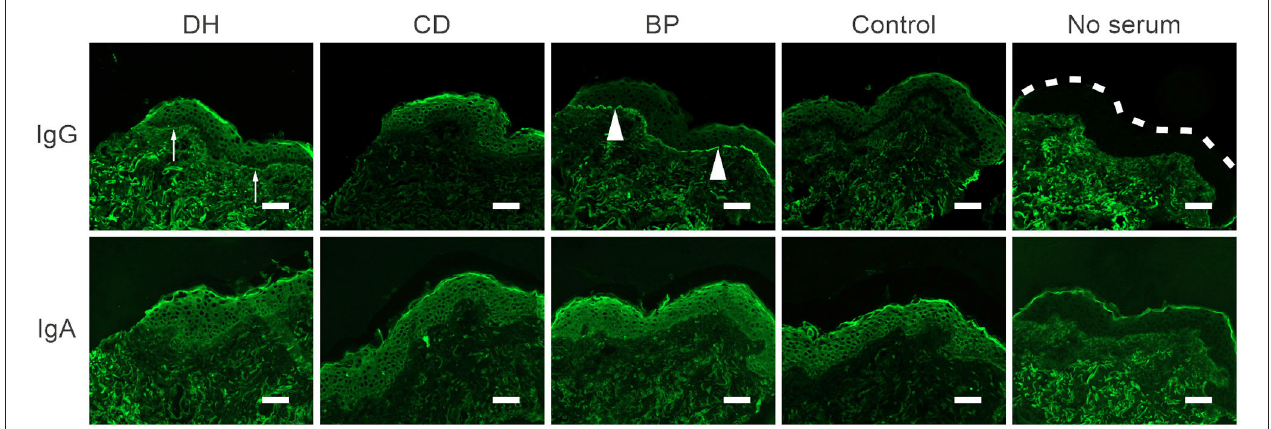
FIGURE 4 | Autoantibodies in DH, CD and control sera do not react with the cutaneous basement membrane zone. Representative images of indirect immunofluorescence (IIF) analysis in frozen human skin sections. 13 DH, 9CD, and 9 control sera were tested with anti-human IgG-FITC or IgA-FITC as a secondary antibody. BP serum served as a positive control. IgG-autoantibodies in BP sera bound linearly to the basement membrane zone of human skin (arrowheads) and two DH and two CD sera showed faint positive depositions (arrows). All IIF analysis with anti-IgA were negative. Scalebar = 50 µ m, dashed line marks the epidermal edge. BP, bullous pemphigoid; CD, coeliac disease; Ctrl, control; DH, dermatitis